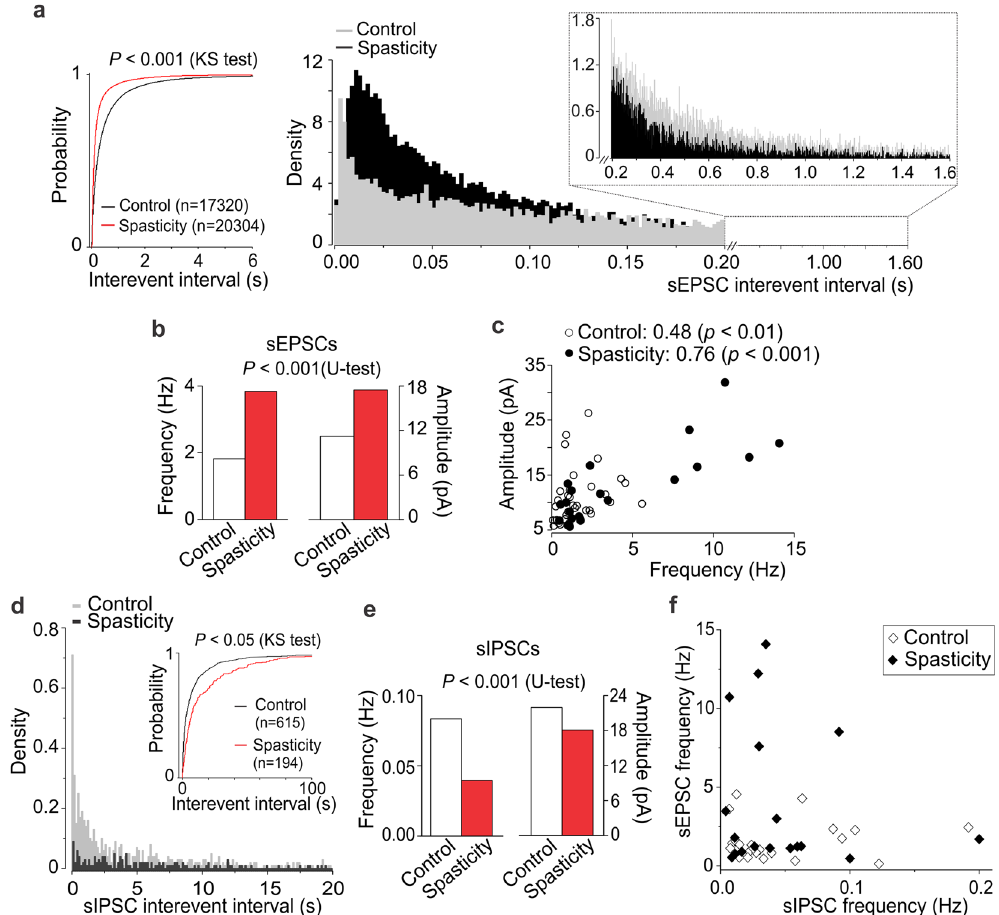
Figure 2. The SCI-induced hyperexcitability of the DH results from boosted excitation and synaptic disinhibition. ( a ) Voltage-clamp recordings in the DH interneurons (Vh = − 70 mV) unveiled boosted circuitry excitation post-SCI. Cumulative probability plots (left) and the probability density functions for the inter-event interval of sEPSCs (right) demonstrate the high-frequency sEPSCs post-SCI and opposite the low-frequency sEPSCs in control (insert). ( b ) Summary for the median frequency (left Y axis) and the median amplitude (right Y axis) of sEPSCs in control and spasticity. ( c ) The median sEPSC frequency plotted against its median amplitude, estimated for each individual neuron (n = 34 cells from control and n = 21 cells from spastic animals). The Spearman correlation coefficients and the Spearman’s non-parametric test significance are indicated. ( d ) Voltage-clamp recordings of sIPSCs in the DH interneurons (Vh = 0 mV) revealed the decreased density of inhibitory currents post-SCI. Cumulative probability plots for the sIPSC inter-event interval in experimental groups (insert). ( e ) Summary for the median frequency (left Y axis) and the median amplitude (right Y axis) of sIPSCs in different conditions. ( f ) The median frequency of sEPSCs plotted against the median frequency of sIPSCs recorded from the same neurons in control (n = 24 cells) and spasticity (n = 18 cells). The Kolmogorov-Smirnov (KS) or the Mann-Whitney U-test significance is